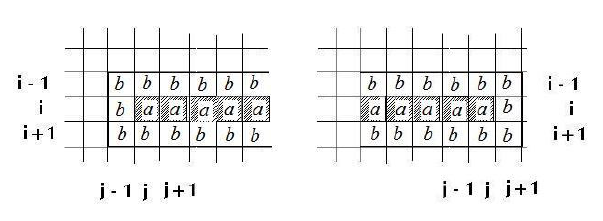
Figure 4. Space-oriented filter masks